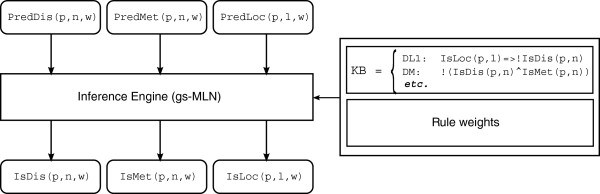
Refinement pipeline.